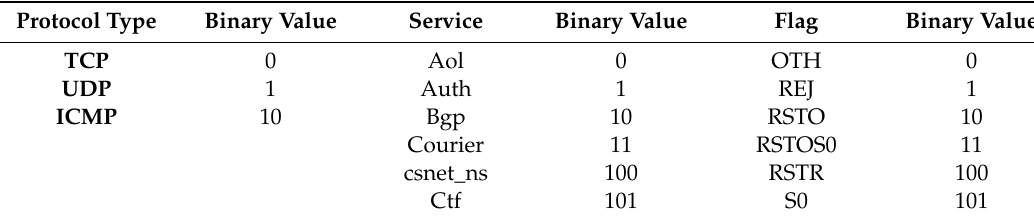
Table 1. Nominal features mapping into a binary representation.